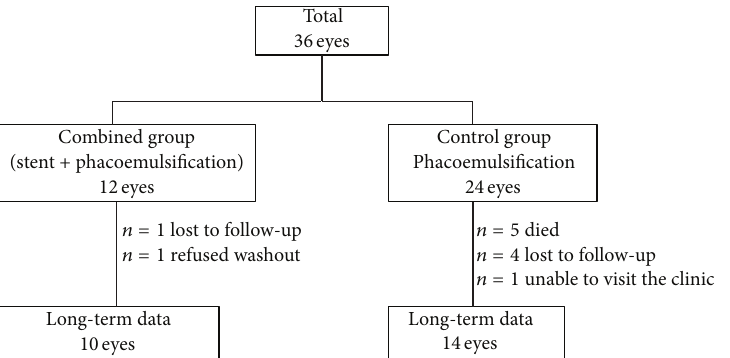
Figure 1: Subject accountability: a total of 10 eyes in the combined group and 14 eyes in the control group had long-term follow-up data.